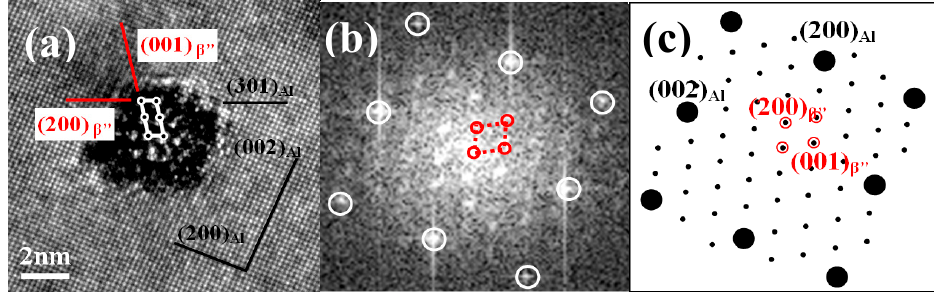
Figure 12. Granular-shaped precipitate in the peak-aged Alloy 1 (165 °C/360 min) observed via the <010> Al direction: ( a ) HRTEM image; ( b ) corresponding fast Fourier transform (FFT); ( c ) simulated pattern.